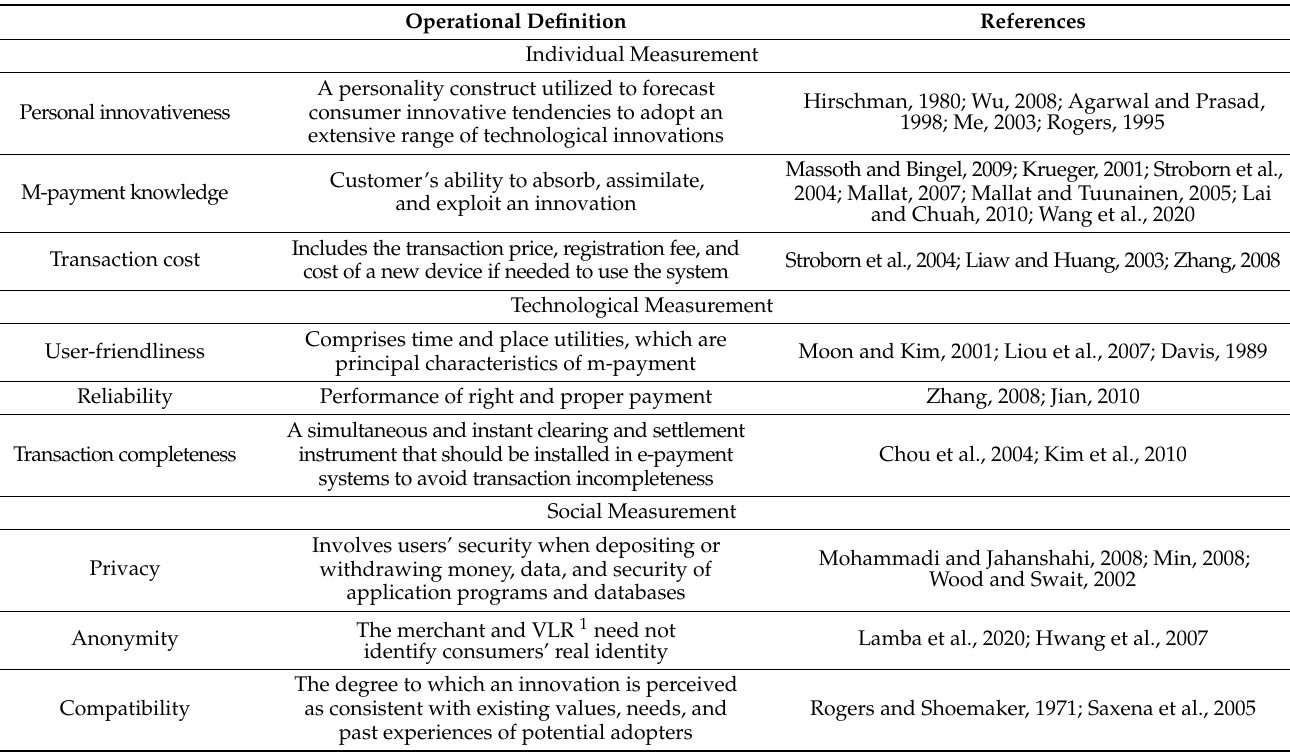
Table 1. Operational definitions of each